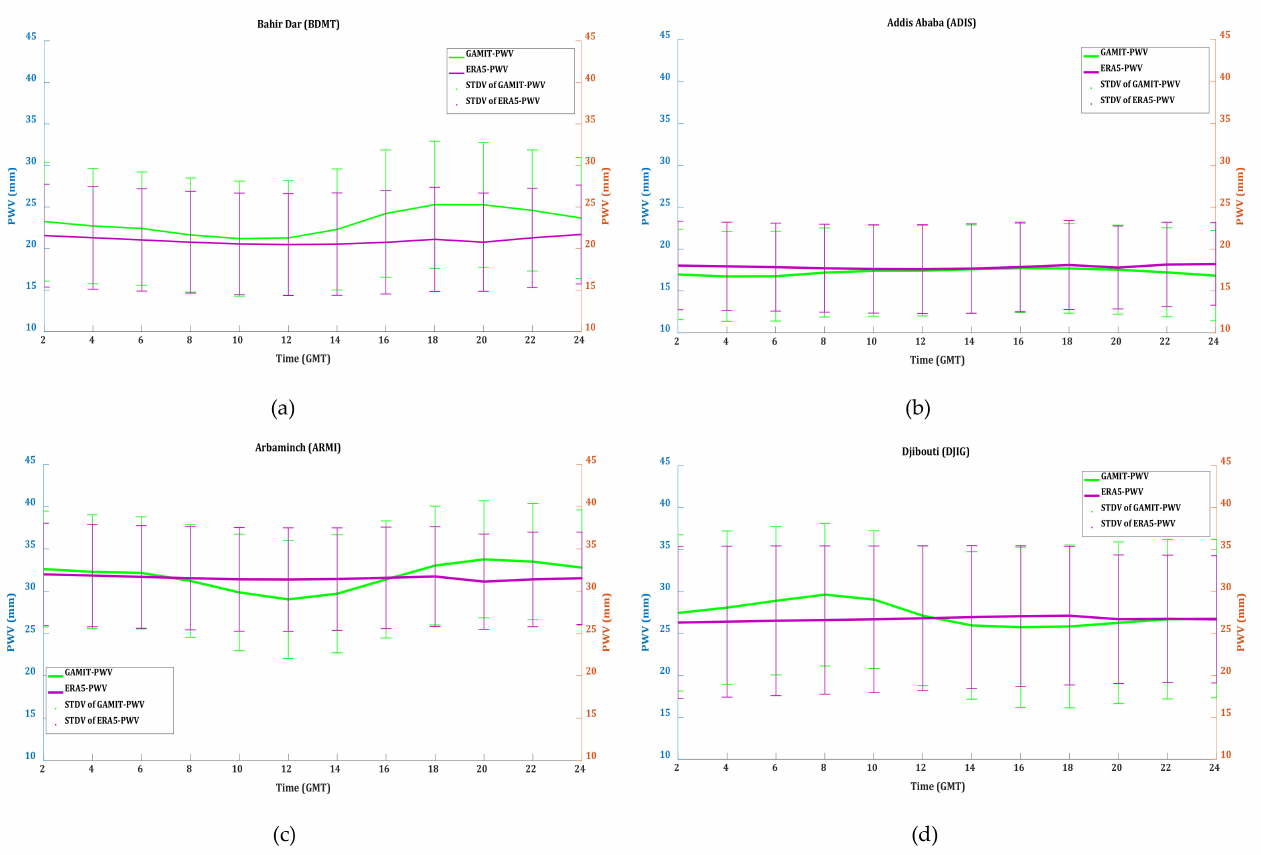
Figure 5. Diurnal cycles in the GAMIT-PWV and ERA5-PWV datasets at the ( a ) BDMT,( b ) ADIS, ( c ) ARMI, and ( d ) DJIG stations. The inter-day variability is represented with vertical bars and denoted by